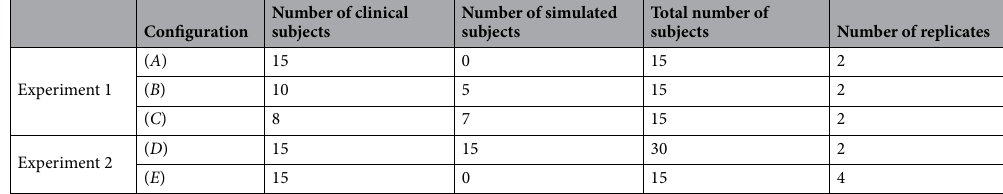
Table 4. Two experiments are presented along with the different configurations studied to compare the performance of an algorithm for automated fetal brain tissue segmentation. For each configuration, the respective number of clinical cases and simulated subjects, and the total number of subjects involved in the cross-validation are reported, as well as the number of times standard augmentation is performed (number of